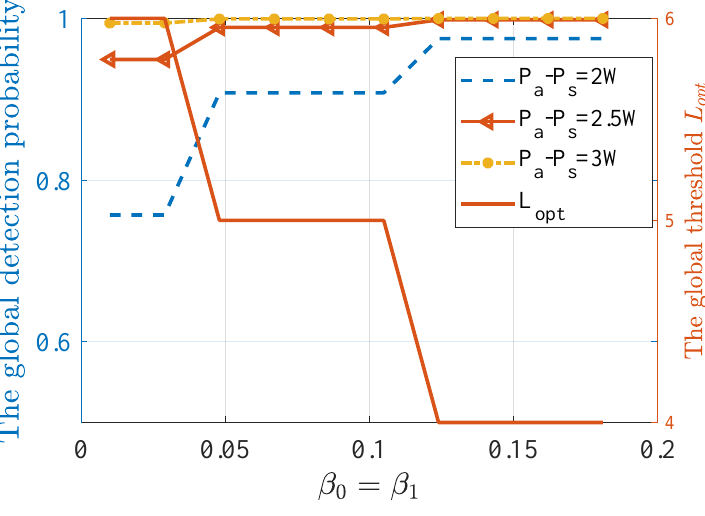
Figure 6. Global detection performance under different false-alarm constraints, which can reflect the compromise between false alarm probability and detection